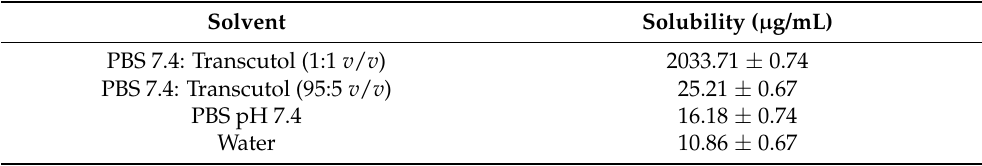
Table 1. Solubility of BCT in aqueous solutions tested by absorption spectroscopy.